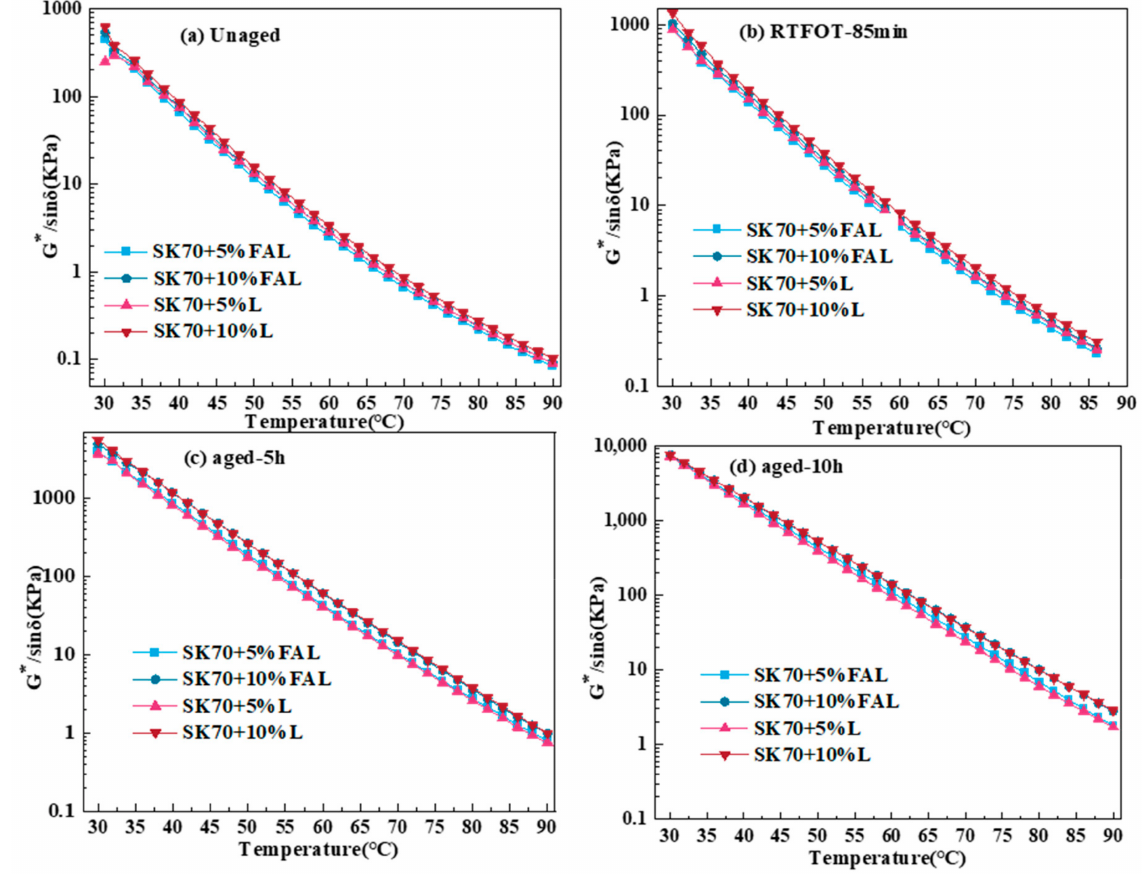
Figure 6. Curves of rutting factor (G*/sin δ ) with temperatures for each asphalt specimen during different aging